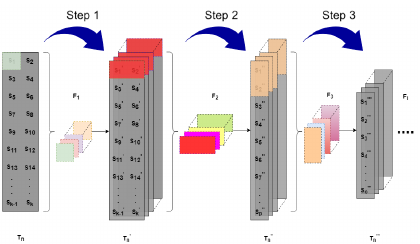
Figure 2. Proposed stacked convolutional neural network